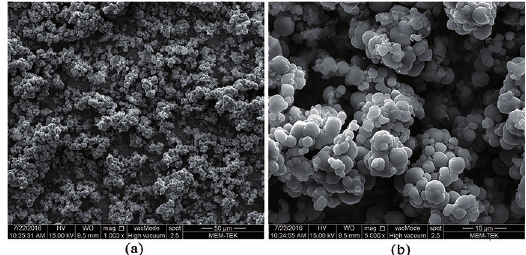
Figure 6: FEGSEM micrographs of the coating grown by using substrate heating method at water bath and heating resistance temperatures of 30 0 C and 140 0 C, respectively, after 42 h of synthesis, as shown at magnifications of (a) x1000 and (b) x5000.